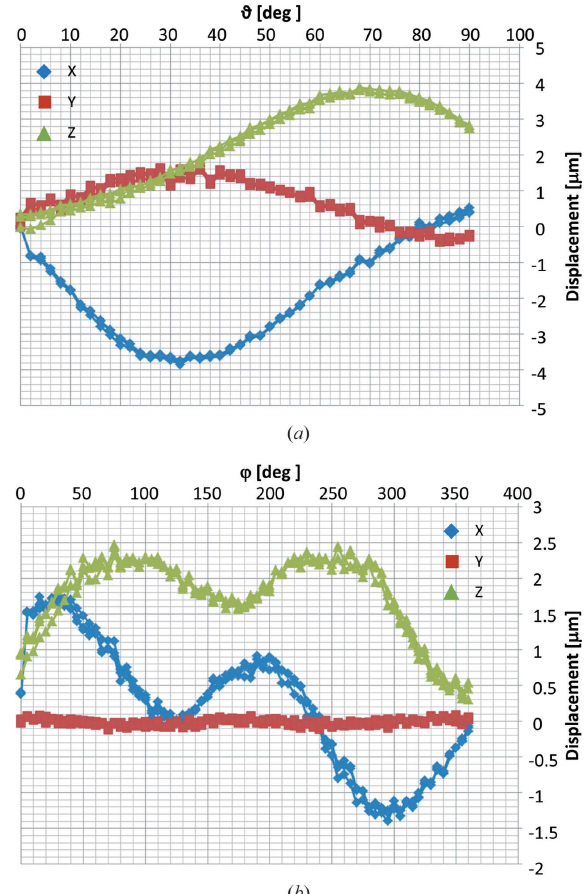
Figure 8 Measurement of the sphere of confusion of the goniometer circles ( a ) # and ( b ) ’ , evaluated from the lateral displacement of a polished sphere placed on a rigid support in the center of the assembly. Three repetitions of a full rotation are performed for each circle, separately. Repeatability of the movement is visible from the overlap of the data points. (Courtesy of Huber GmbH & Co.,